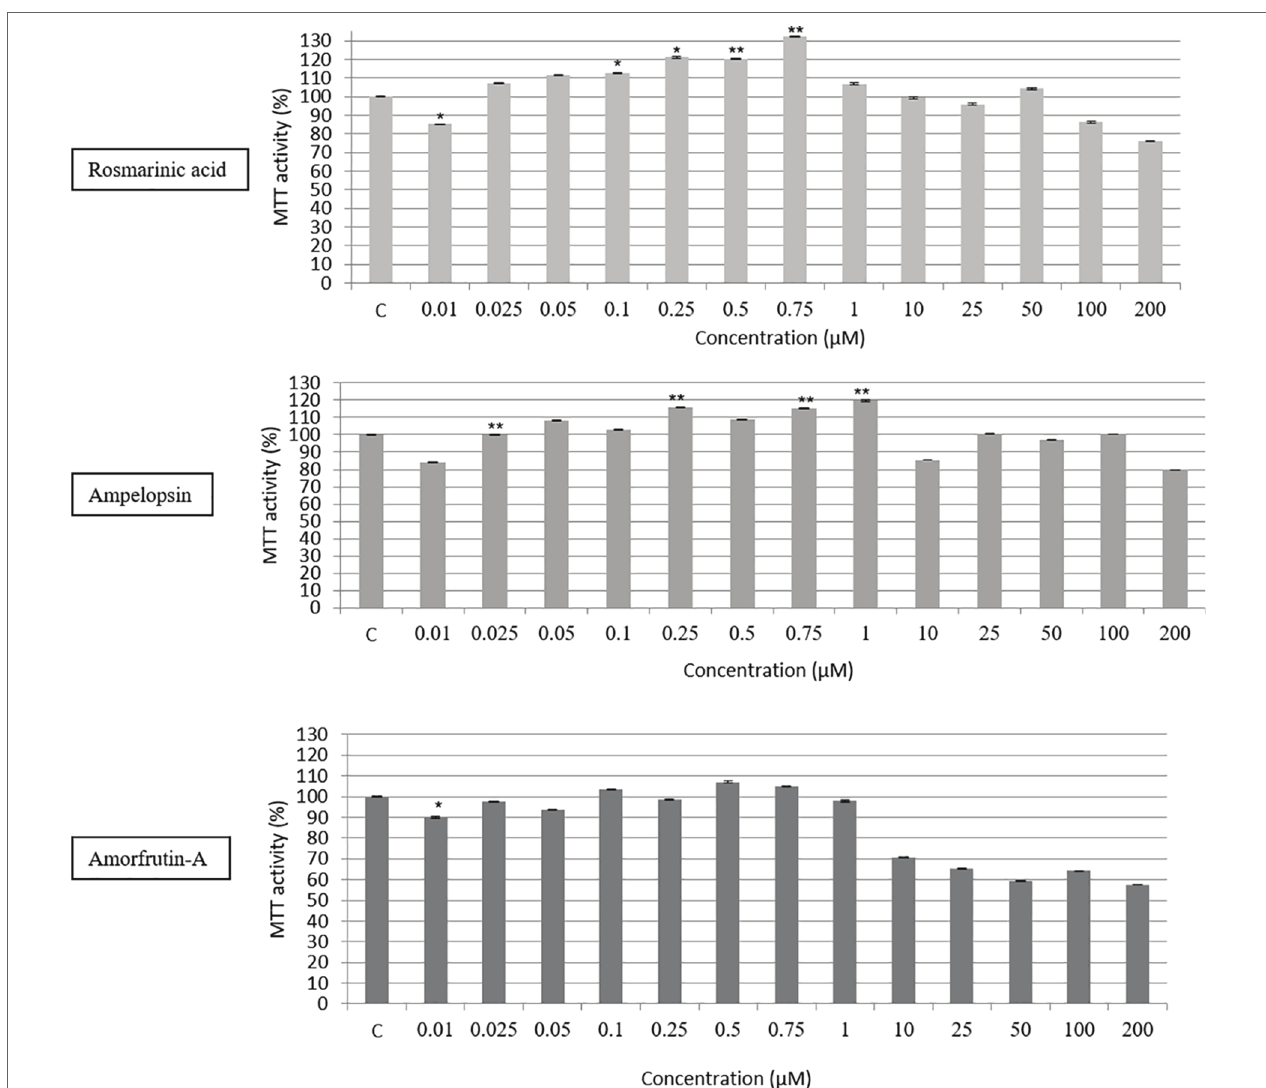
FIGURE 2 | Dose response testing (between 0.01 and 200 μ M) of ROSM, AMPEL, and AMOR on the metabolic activity and survival of early passage PCS cells (p17), as determined by the MTT assay. The bars indicate the ±SD; n = 6, in terms of independent wells; ** p < 0.01, * p < 0.05, as determined by Student’s t